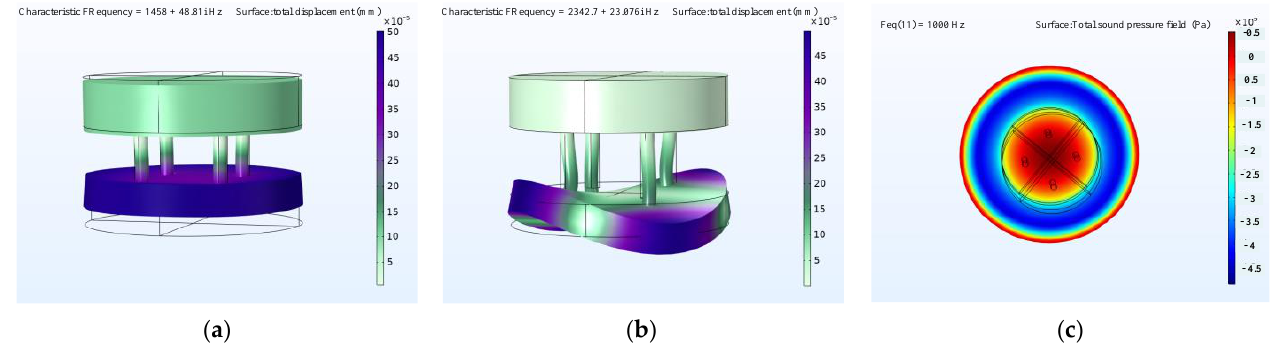
Figure 10. Modal and harmonic response simulation of Tonpilz Terfenol − D transducer: ( a ) longitudinal vibration mode of the Tonpilz Terfenol − D transducer by FEM; ( b ) flexural vibration mode of the Tonpilz Terfenol − D transducer by FEM; ( c ) results of sound field of the Tonpilz Terfenol − D transducer by FEM.